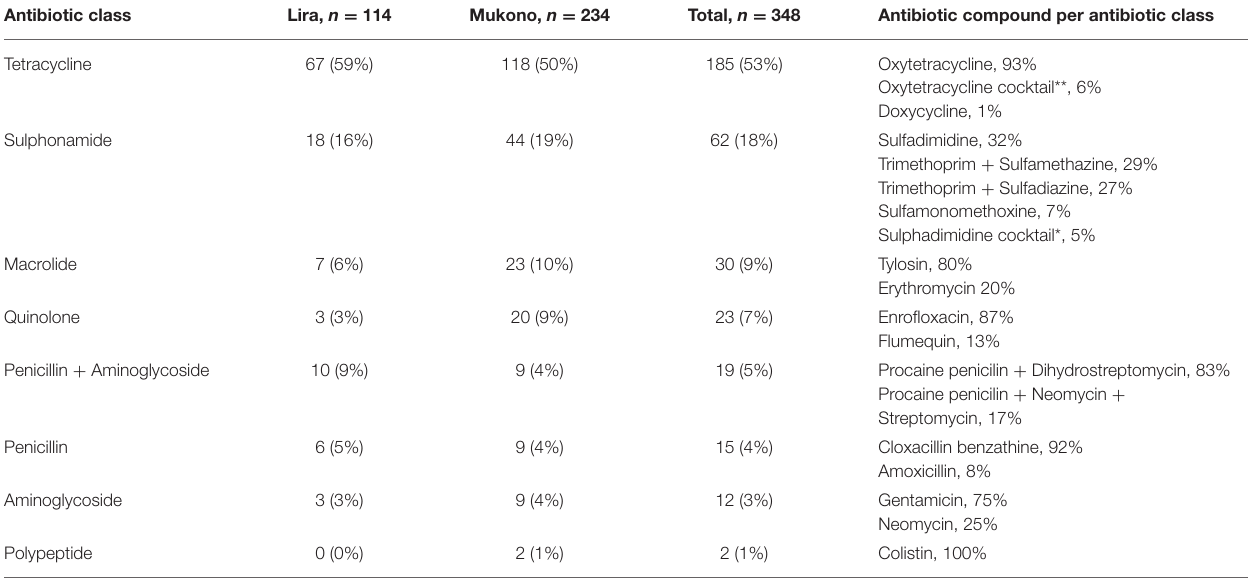
TABLE 3 | Classes of antibiotics stocked in retail shops in Lira and Mukono districts. Antibiotic class Lira, n = 114 Mukono, n = 234